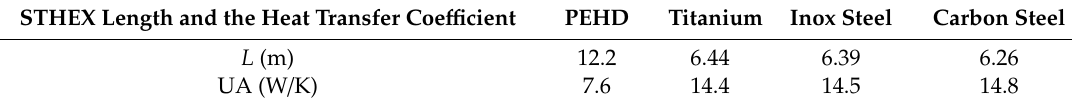
Table 6. Simulation results